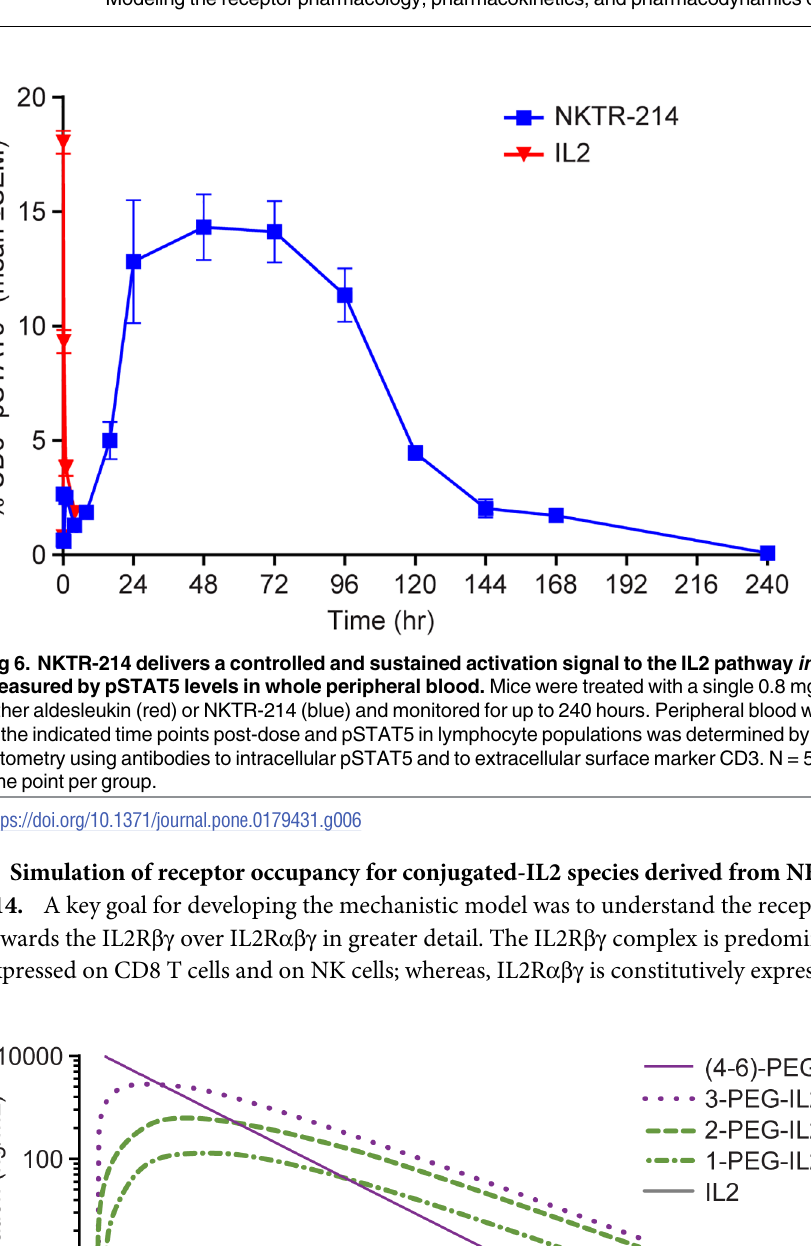
Fig 7. Model-calculated concentration–time profile for species of conjugated-IL2 or free-IL2 that could be theoretically generated from a single dose of 0.8 mg/kg NKTR-214. Where data are available, the model agrees closely with the PK data shown in Table 3. The model calculatesthat administration of NKTR-214 results in sustainedconcentrations of conjugated-IL2with exceedingly low concentrations of free- IL2, consistent with its fast in vivo clearance and slow formation from